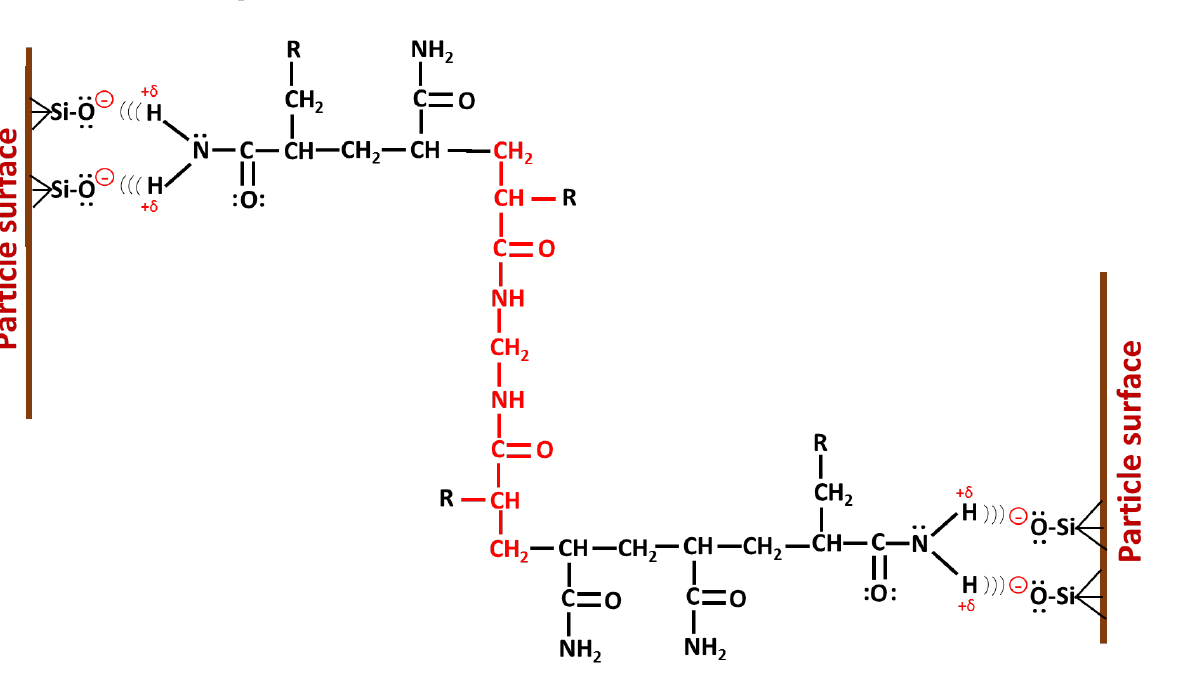
Figure 14. Reaction between an acrylamide molecule physically bound to the surface of the inorganic phase, and a free radical in the reaction medium.